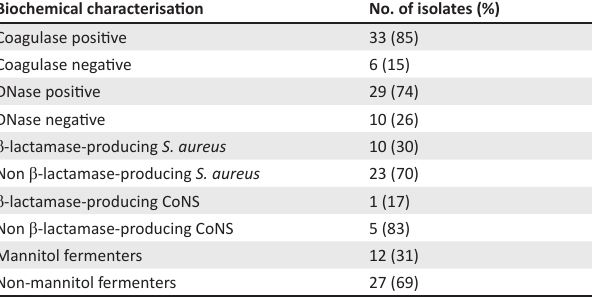
TABLE 2: Summary of biochemical assay on clinical isolates. Biochemical characterisation